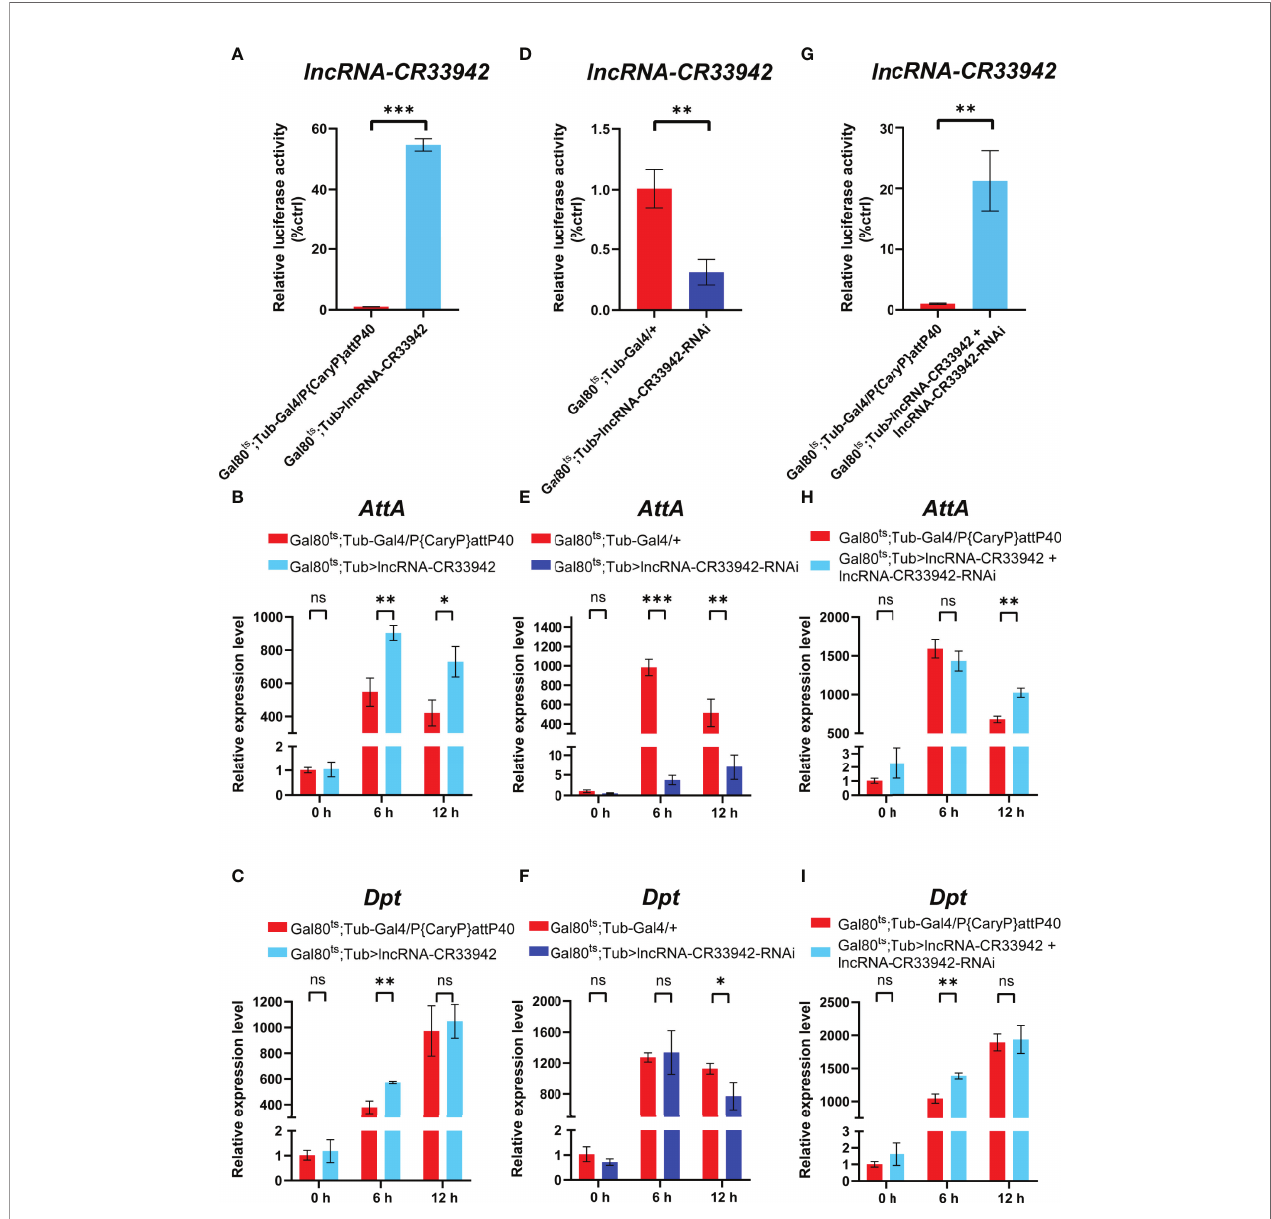
FIGURE 1 | lncRNA-CR33942 regulates Imd pathway AMPs after Escherichia coli infection. The expression levels of lncRNA-CR33942 (A, D, G) , AttA (B, E, H) and Dpt (C, F, I) in lncRNA-CR33942 -overexpressing fl ies, lncRNA-CR33942 -RNAi fl ies, and lncRNA-CR33942 + lncRNA-CR33942 -RNAi co-overexpressing fl ies at different time points (0, 6, and 12 h) after E. coli infection. *P < 0.05; **P < 0.01; ***P < 0.001; ns, not signi fi cantly different from the